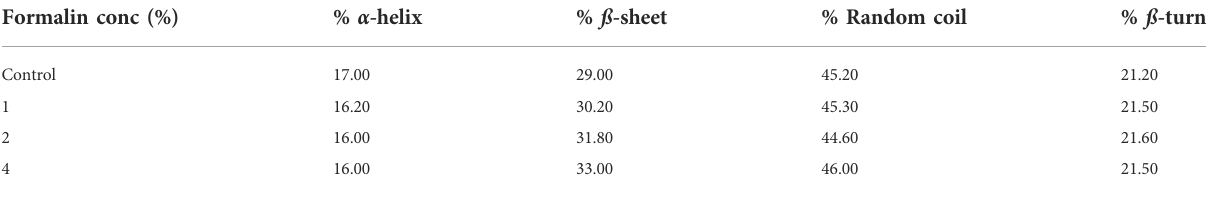
TABLE 2 Secondary structure analysis of alpha-Chymotrypsin in presence of formalin. Formalin conc